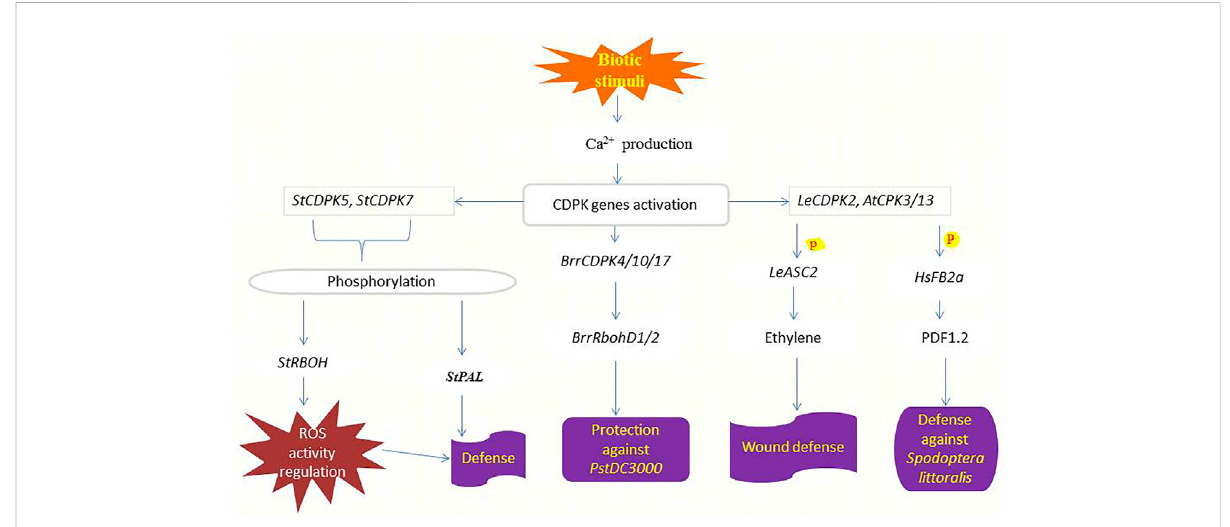
FIGURE 3 Functions of CDPKs in defending crops against pathogens and herbivore attacks. Upon sensing biotic stimuli or danger, the production of Ca 2+ increases leading to theactivation of various CDPKs responsible for inducing pathogen orherbivory resistance. StCDPK5 phosphorylates StRBOH to regulateROSactivityhenceconferring defense response(Kobayashietal.,2007),likewise, StCDPK7 phosphorylates StPAL toinducedefense against Phytophthorainfestans (Fantinoetal.,2017). BrrCDPKs interactwith BrrRbohD1/2 torepressthereproductionof pstDC3000 (Wangetal.,2017). Elevated cytosolic Ca 2+ triggers the production of LeCDPK2 upon wounding which phosphorylates ( P ) LeASC2 leading to the generation and accumulation of ethylene and fi nally the induction of defense-related genes for protection (Kamiyoshihara et al., 2010). AtCPK3/13 also responds to wounding by phosphorylating ( P ) HsFB2a thereby regulating the transcript level of the PDF1.2 to induce resistance against Spodoptera littoralis attacks (Kanchiswamy et al.,